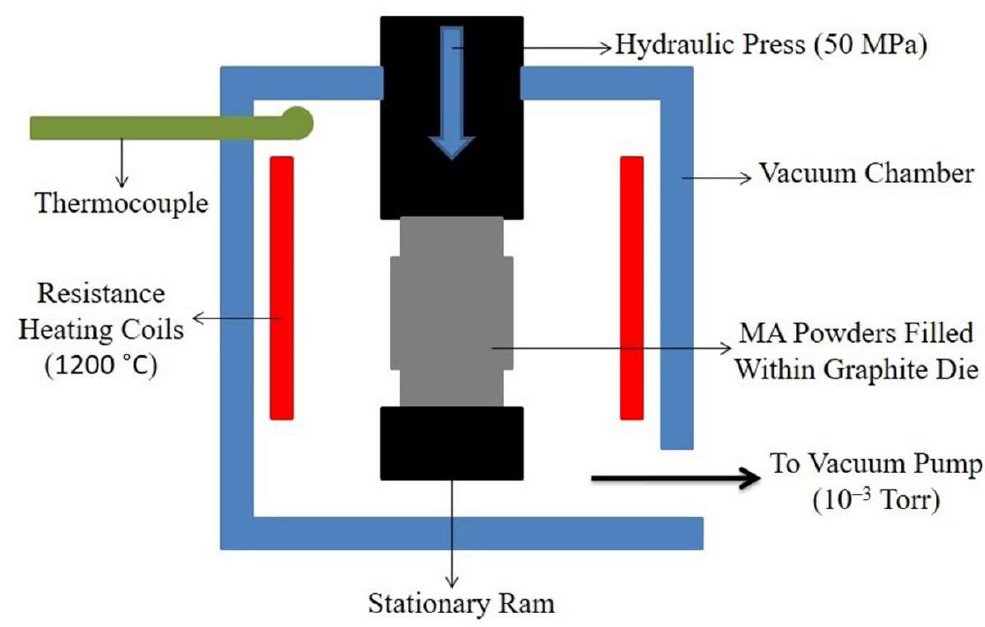
Figure 1. Schematic representation of vacuum hot pressing.